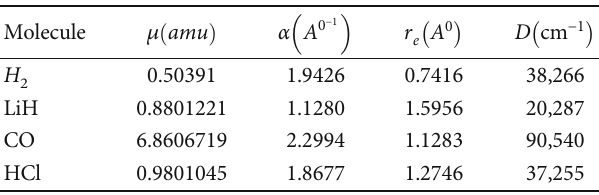
Table 1: The potential model parameters for some diatomic molecules [18 –